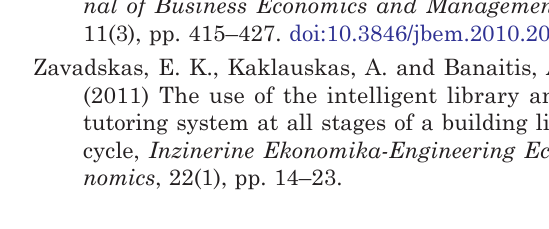
lams įgyvendinti buvo sukurtas originalus integruotas pasyviųjų namų analizės modelis ir pasyviųjų namų projektų analizės daugiakriterinė sprendimų paramos sistema, kuria remiantis galima analizuoti pasyviojo namo gyvavimo ciklą, suinteresuotas projekto grupes ir projekto mikro-, mezo- bei makroaplinką kaip vieną integruotą